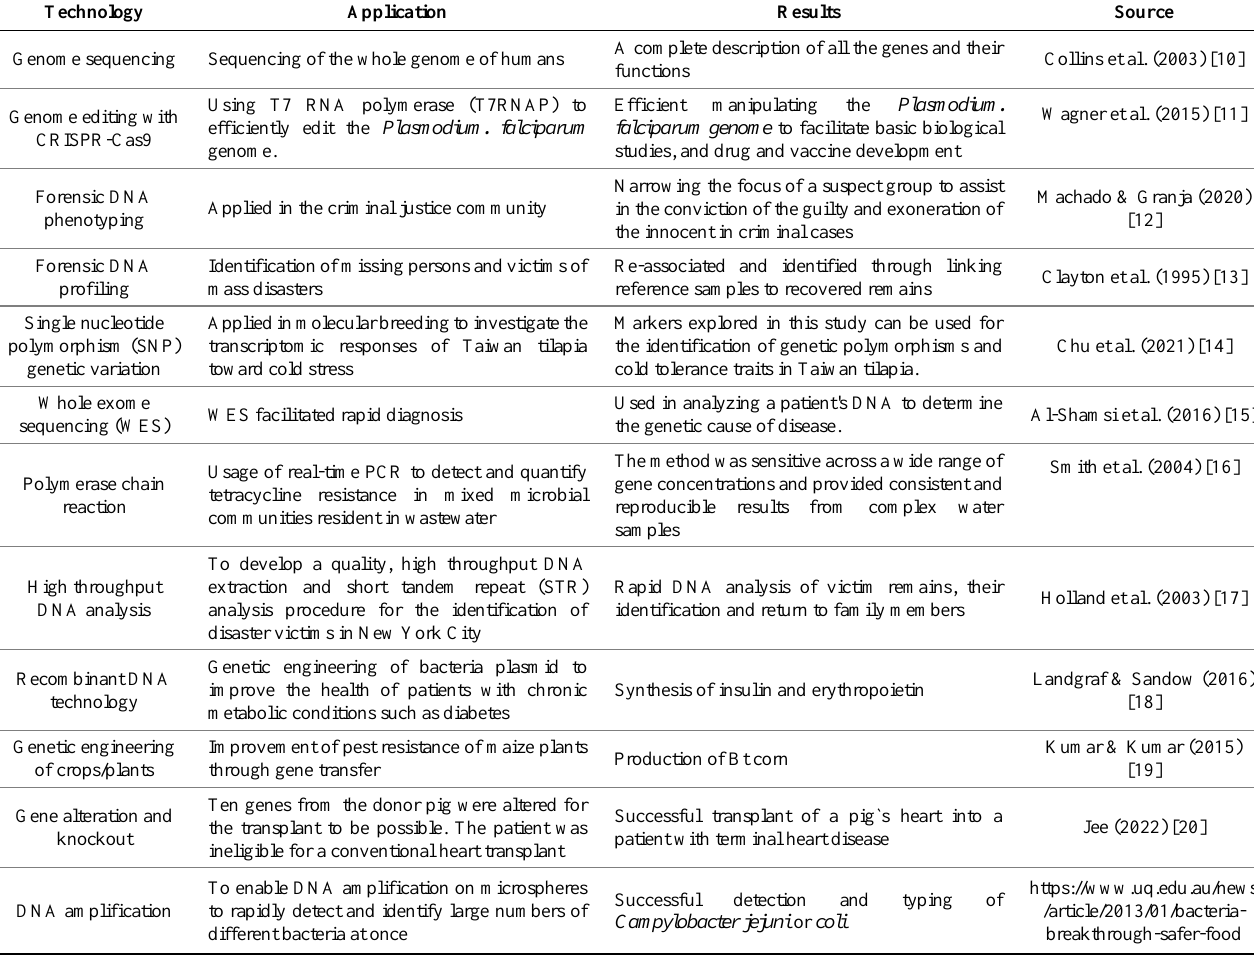
Table 1. Some Current DNA Technologies and Milestone Achievements Globally